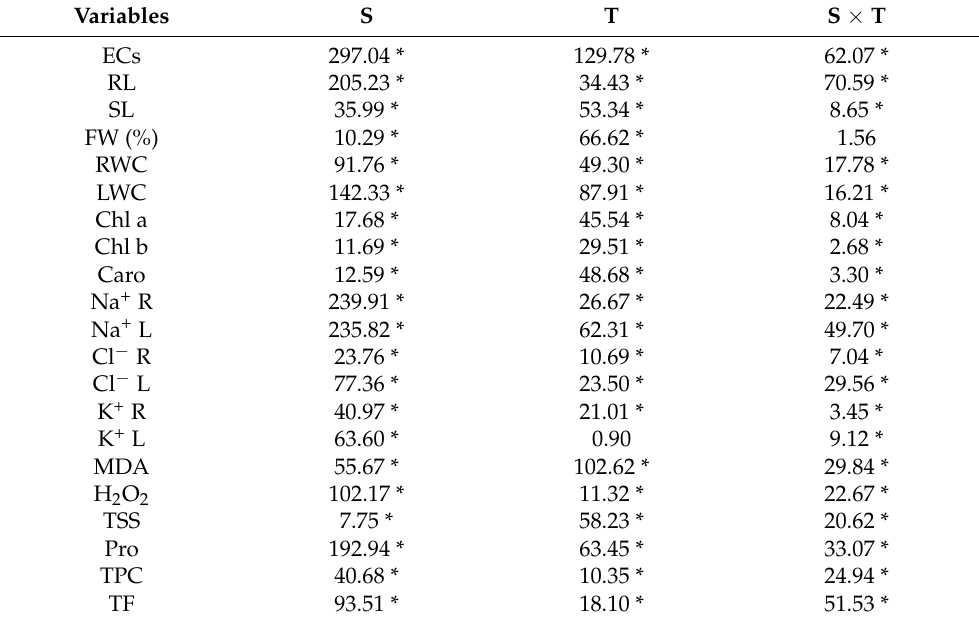
Table 1. Results of two-way ANOVA (F ratios) for the independent factors ‘Species’ (S), ‘Treatment’ (T) and the interaction ‘Species × Treatment’ (S × T). Abbr.: ECs: electrical conductivity of the substrate; RL: root length; SL: shoot length; FW(%): leaf fresh weight (as a percentage of the